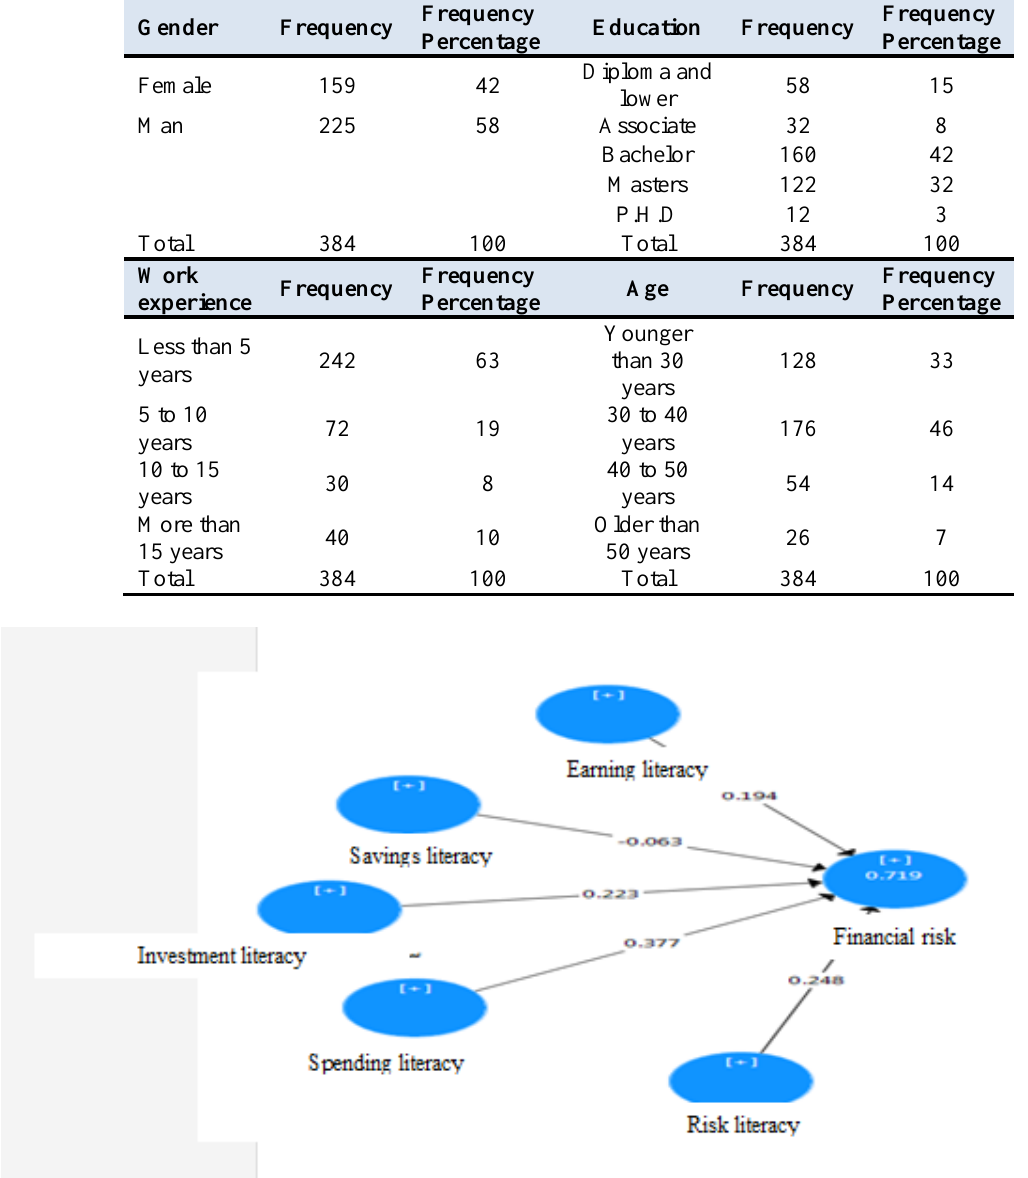
Figure 1: The model of impact coefficients regarding factor load